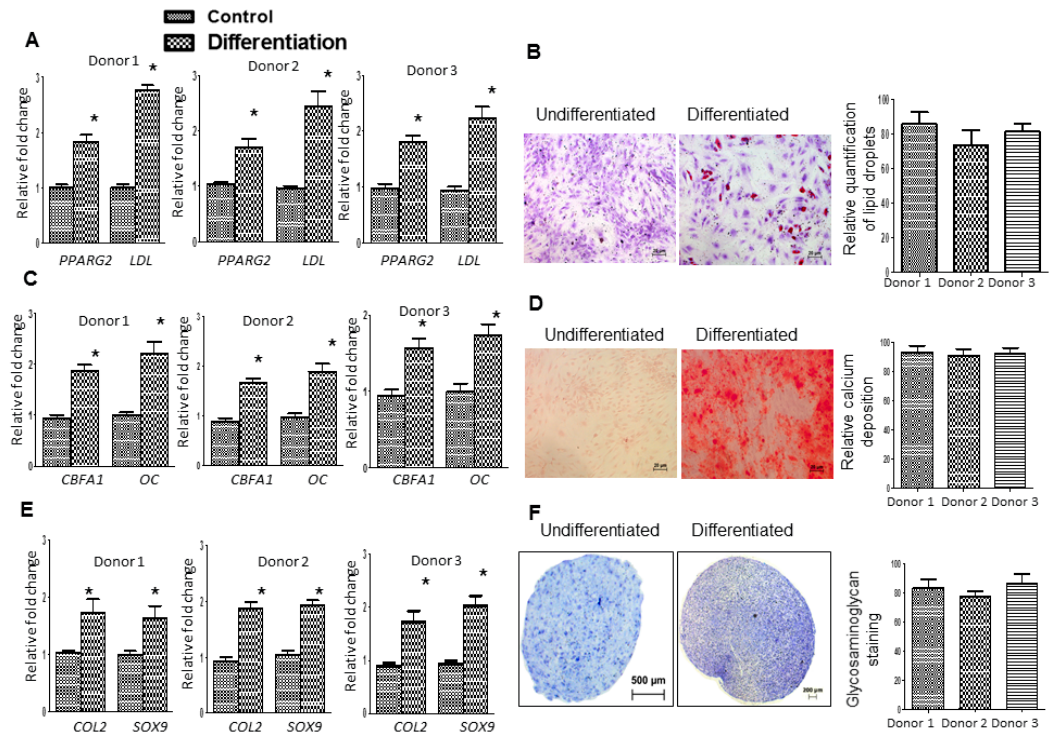
Figure 2. Lineage-specific differentiation capacity of ad-MSCs. ( A , B ) RT-qPCR was done to evaluate adipogenesis markers, Peroxisome proliferator-activated receptor γ 2 (PPARG2 ), and Lipoprotein lipase (LPL ). Quantification of lipid droplets is shown in ( B ) after staining undifferentiated and differentiated samples with Oil Red O. Scale bar: 20 µm; ( C , D ) RT-qPCR was done to evaluate osteogenesis markers, Core-binding factor subunit α 1 (CBFA1 ) and Osteocalcin (OC ). Undifferentiated and differentiated donor ad-MSCs were stained with Alizarin red S. In osteogenic cultures mineralization was visible as red-stained calcium deposition in ( D ). Scale bar: 20 µm; and ( E , F ) RT-qPCR was done to evaluate chondrogenesis markers such as type II collagen ( COL2 ) and Sox9 . Undifferentiated and differentiated donor ad-MSCs were stained with Toluidine blue O. In chondrogenic cultures staining of the proteoglycans (purple) was visible. Quantification of glycosaminoglycans production is shown. Scale bar: Undifferentiated: 500 µm; Differentiated: 200 µm. * p < 0.05.